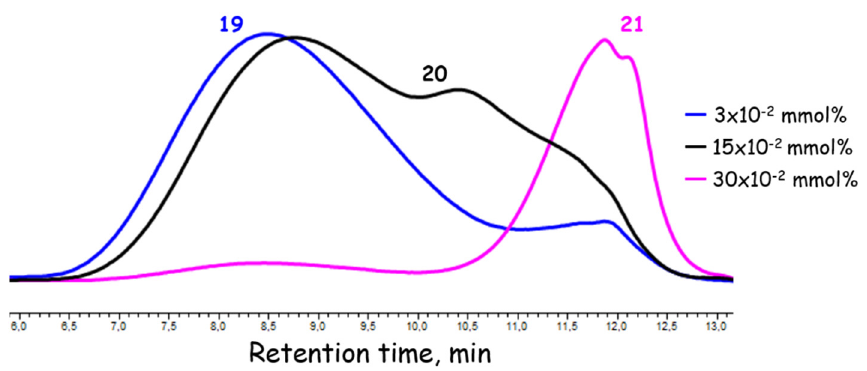
Figure 7. GPC curves obtained in experiments 19 – 21 .